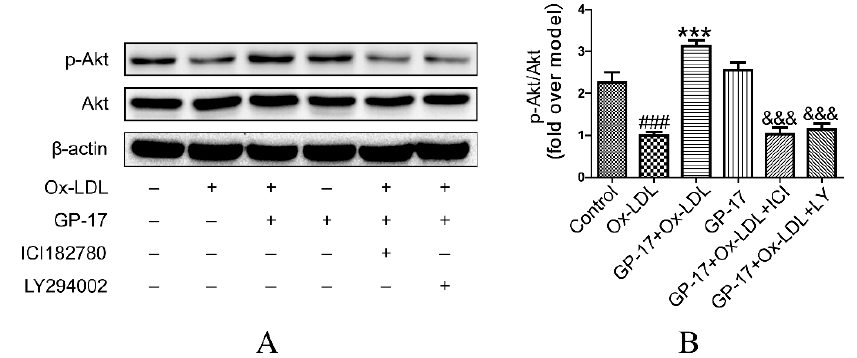
Figure 9. Effect of GP-17 on PI3K/Akt phosphorylation via ER α in Ox-LDL treated HUVECs. ( A , B ) Phosphorylation of Akt mediated by GP-17 in Ox-LDL-induced HUVECs was abolished by pretreatment with ICI182780 or LY294002. The values are expressed as the mean ± S.E.M. from three independent experiments. # p < 0.05; ### p < 0.001 vs. Control; * p < 0.05; *** p < 0.001 vs. Ox-LDL; & p < 0.05; &&& p < 0.001 vs. GP-17 + Ox-LDL. p-Akt, phospho-protein kinase B.